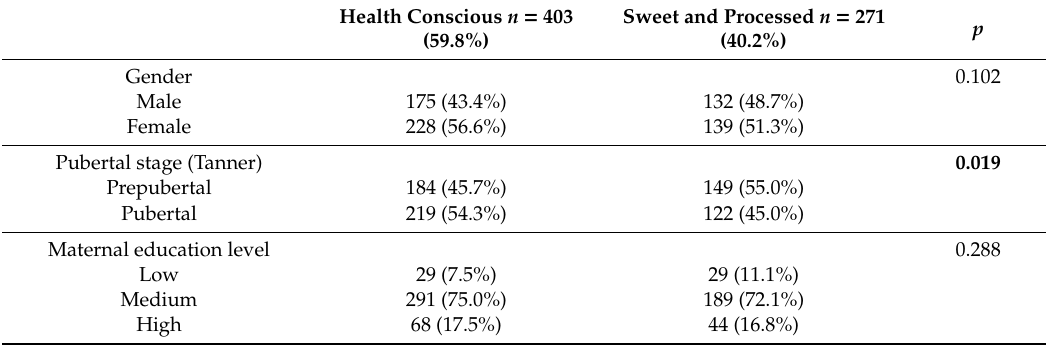
Figure 2. Frequency distribution of BMI subgroups in children and adolescents in each dietary cluster (GENOBOX cohort).